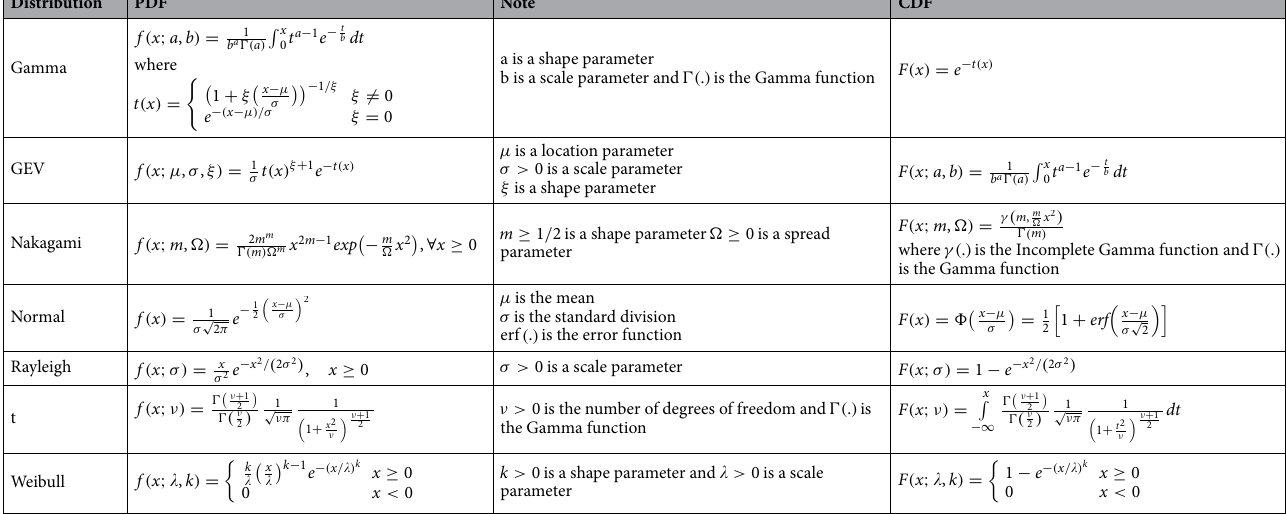
Table 2. The mathematical expressions of distributions.